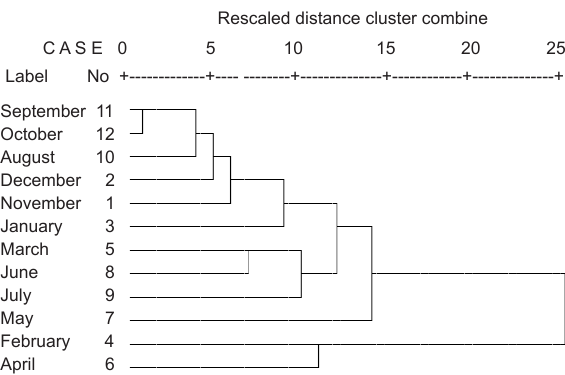
Figure 3. Hierarchical cluster analysis of phytoplankton of Utra Pat (2002-03)